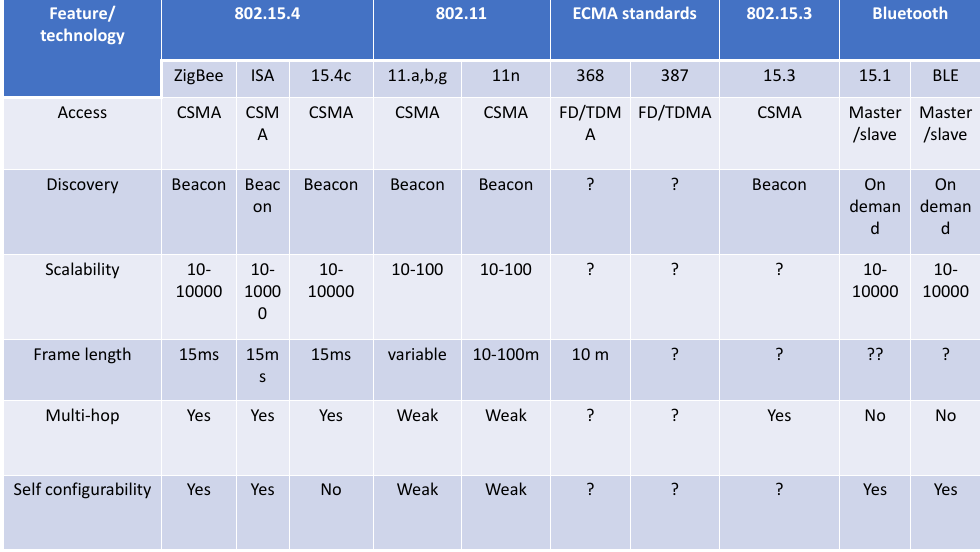
Figure 8. COTS MAC-Layer